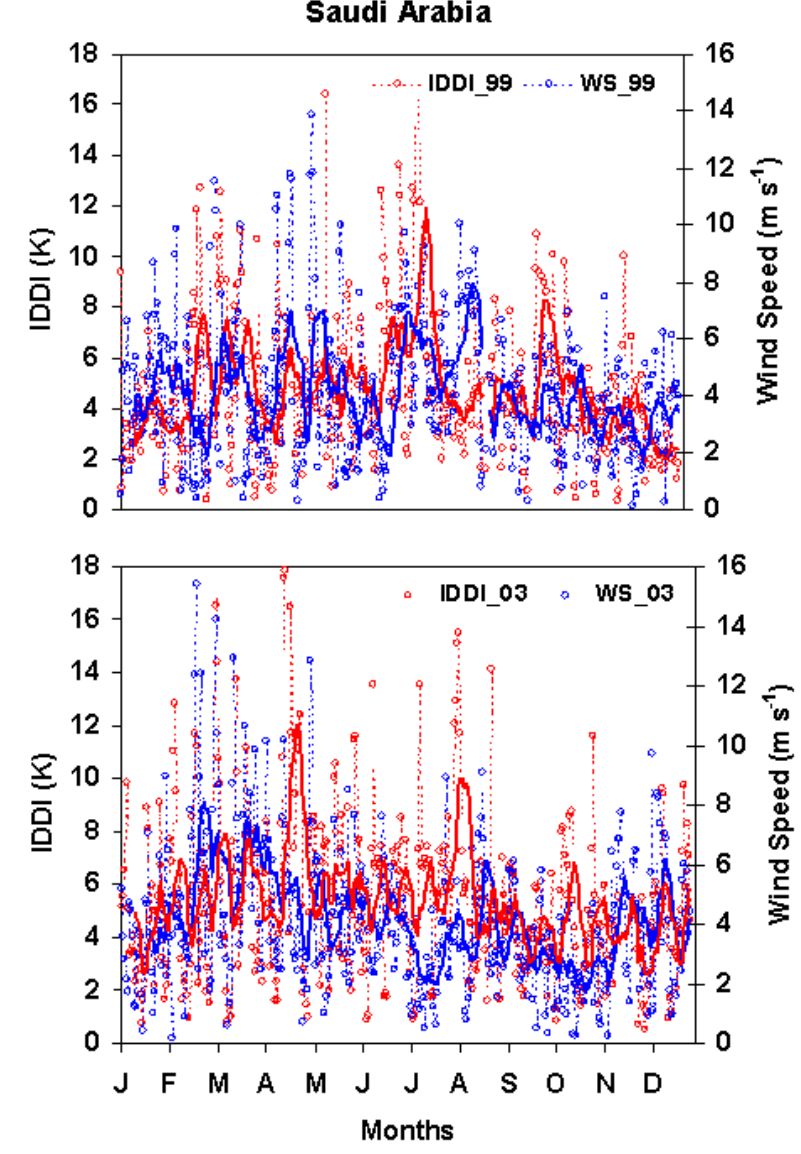
Fig. 4. Daily IDDI and wind speed (dashed lines) for Saudi Arabia-I. Solid line represents 10 day running average.